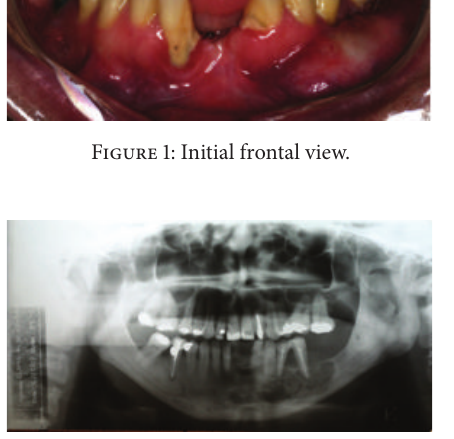
Figure 5: Postoperative X-ray showing surgical margins and the continuity of the base of the mandible.